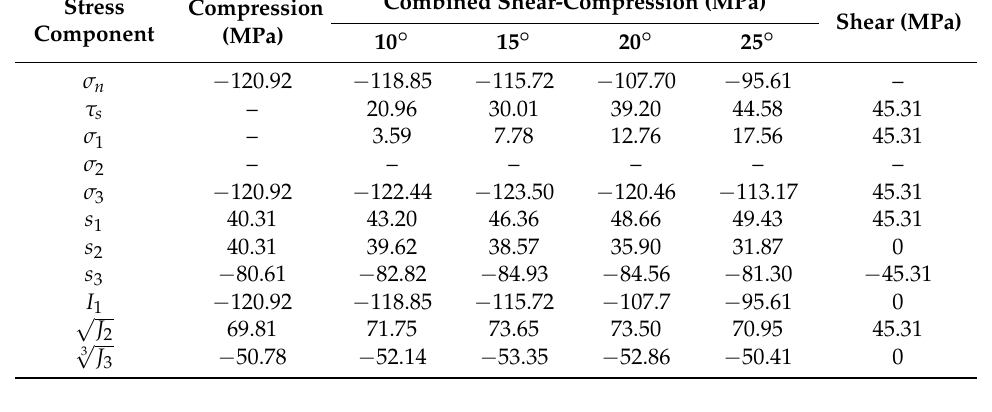
Table 1. Stress components and invariants of PMMA under different loading conditions at yielding.